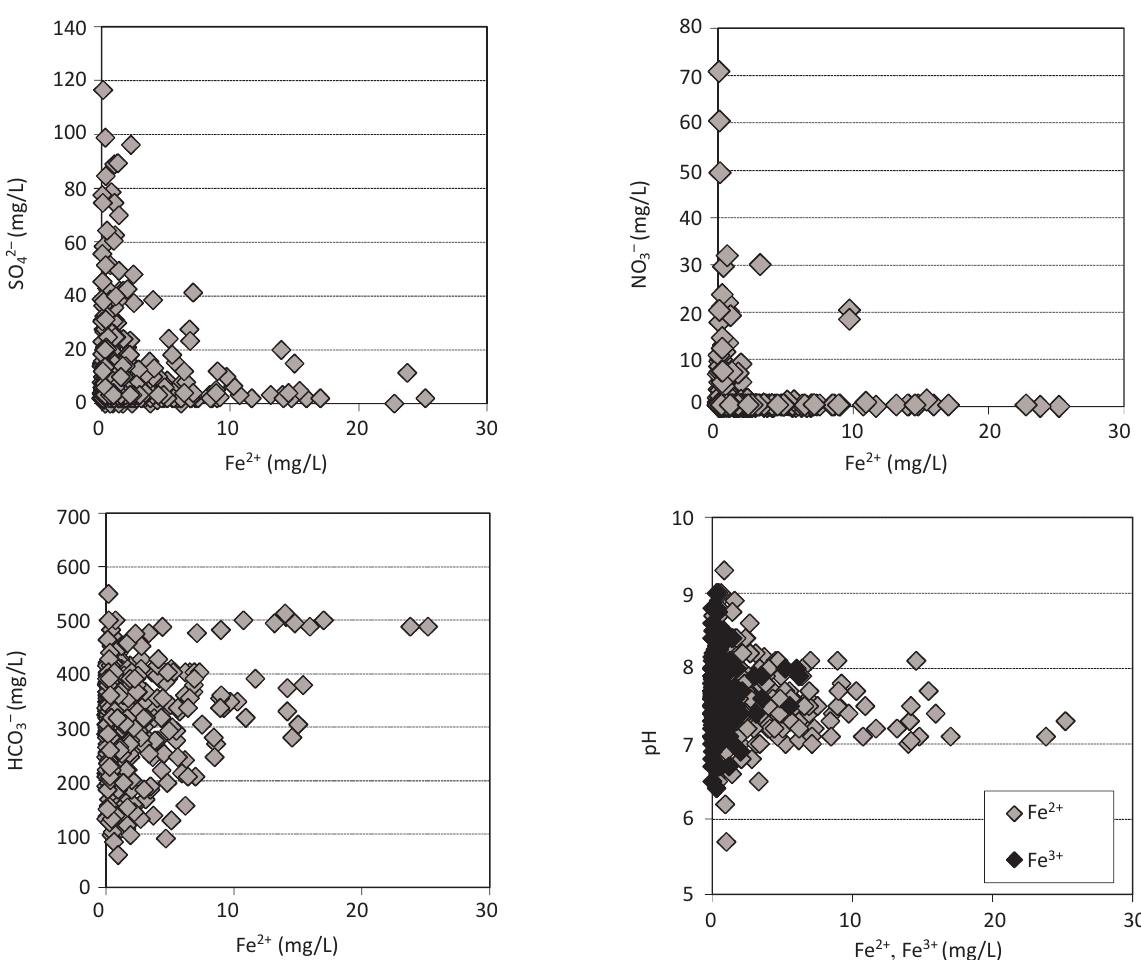
Fig. 5. Fe 2+ and Fe 3+ concentrations in groundwater plotted against the SO 42– , NO 3– and HCO 3– contents and pH